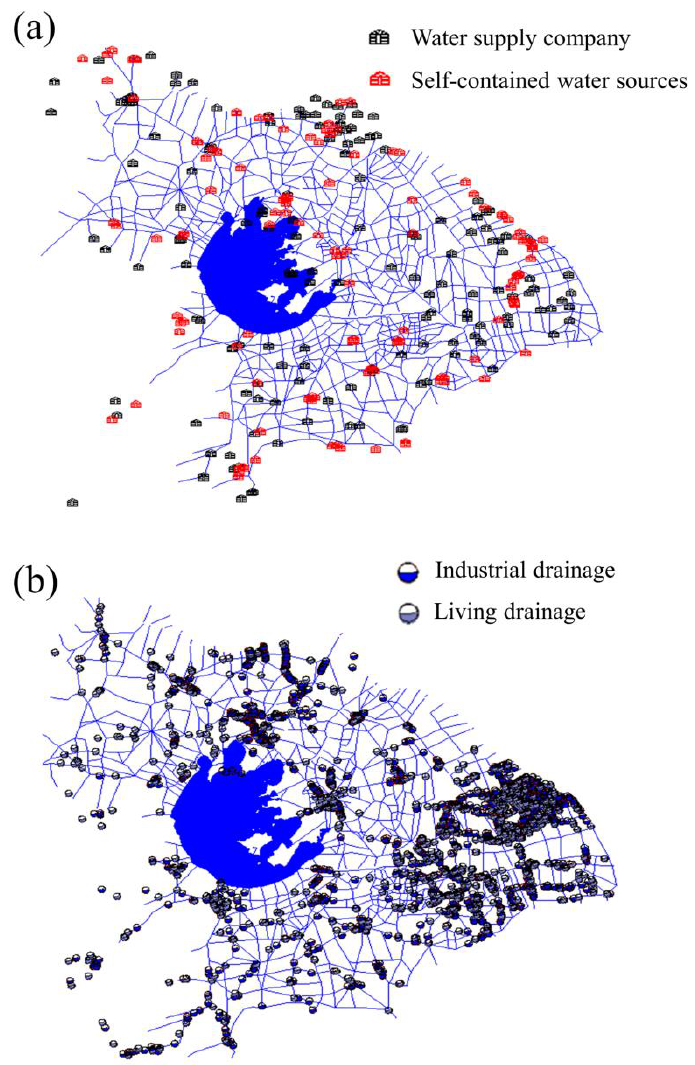
Figure 7. The simulations of distribution ( a ) for water supply companies (black) and self-contained water sources (red); ( b ) drainage in Taihu Basin.